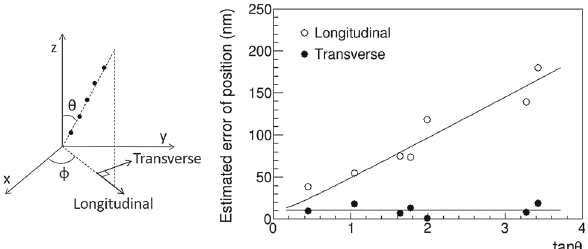
Fig. 7 Left: definition of angles θ and φ of a track and directions of longitudinal and transverse errors. The x–y plane shows the surface of the converter layer. Right: position errors of detected α -tracks in longitudinal and transverse directions in nm and their dependences on track slopes (tan θ )